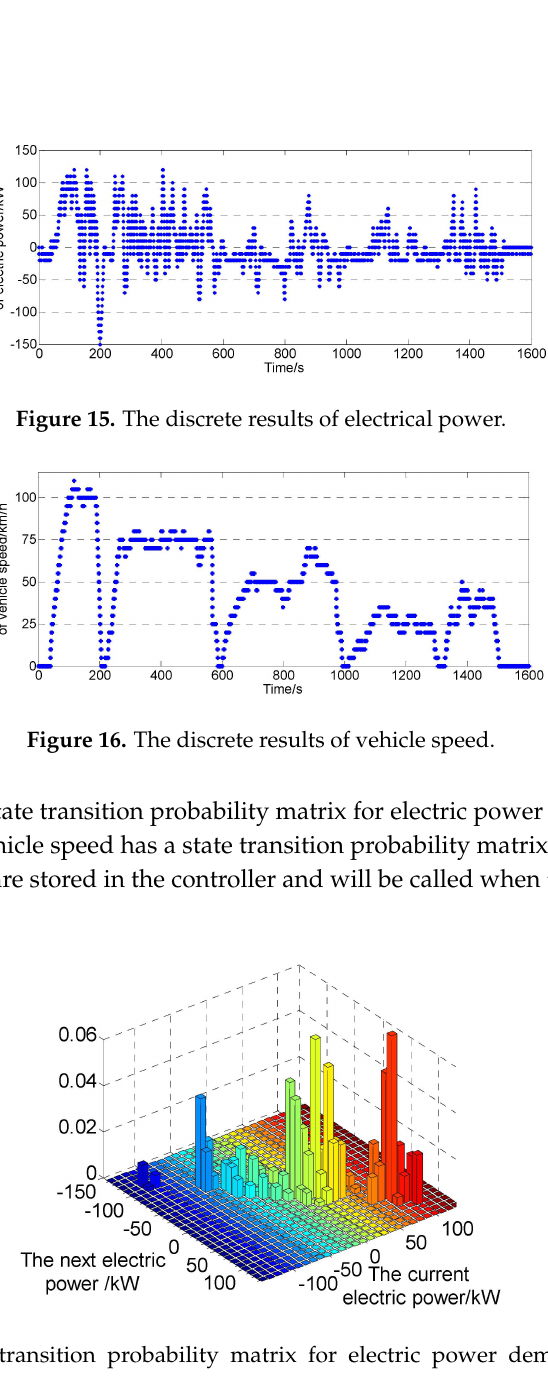
Figure 17. The state transition probability matrix for electric power demand for a 55 km/h vehicle